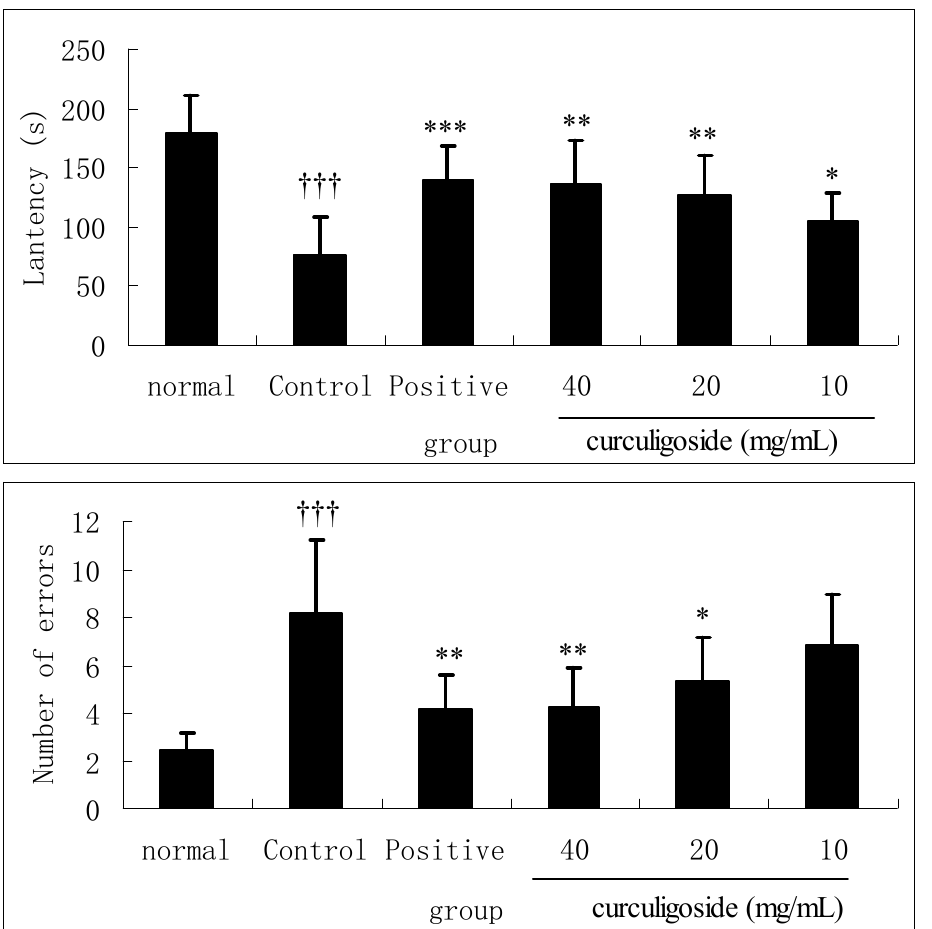
Figure 2. The effect of curculigoside on learning performances in step-down